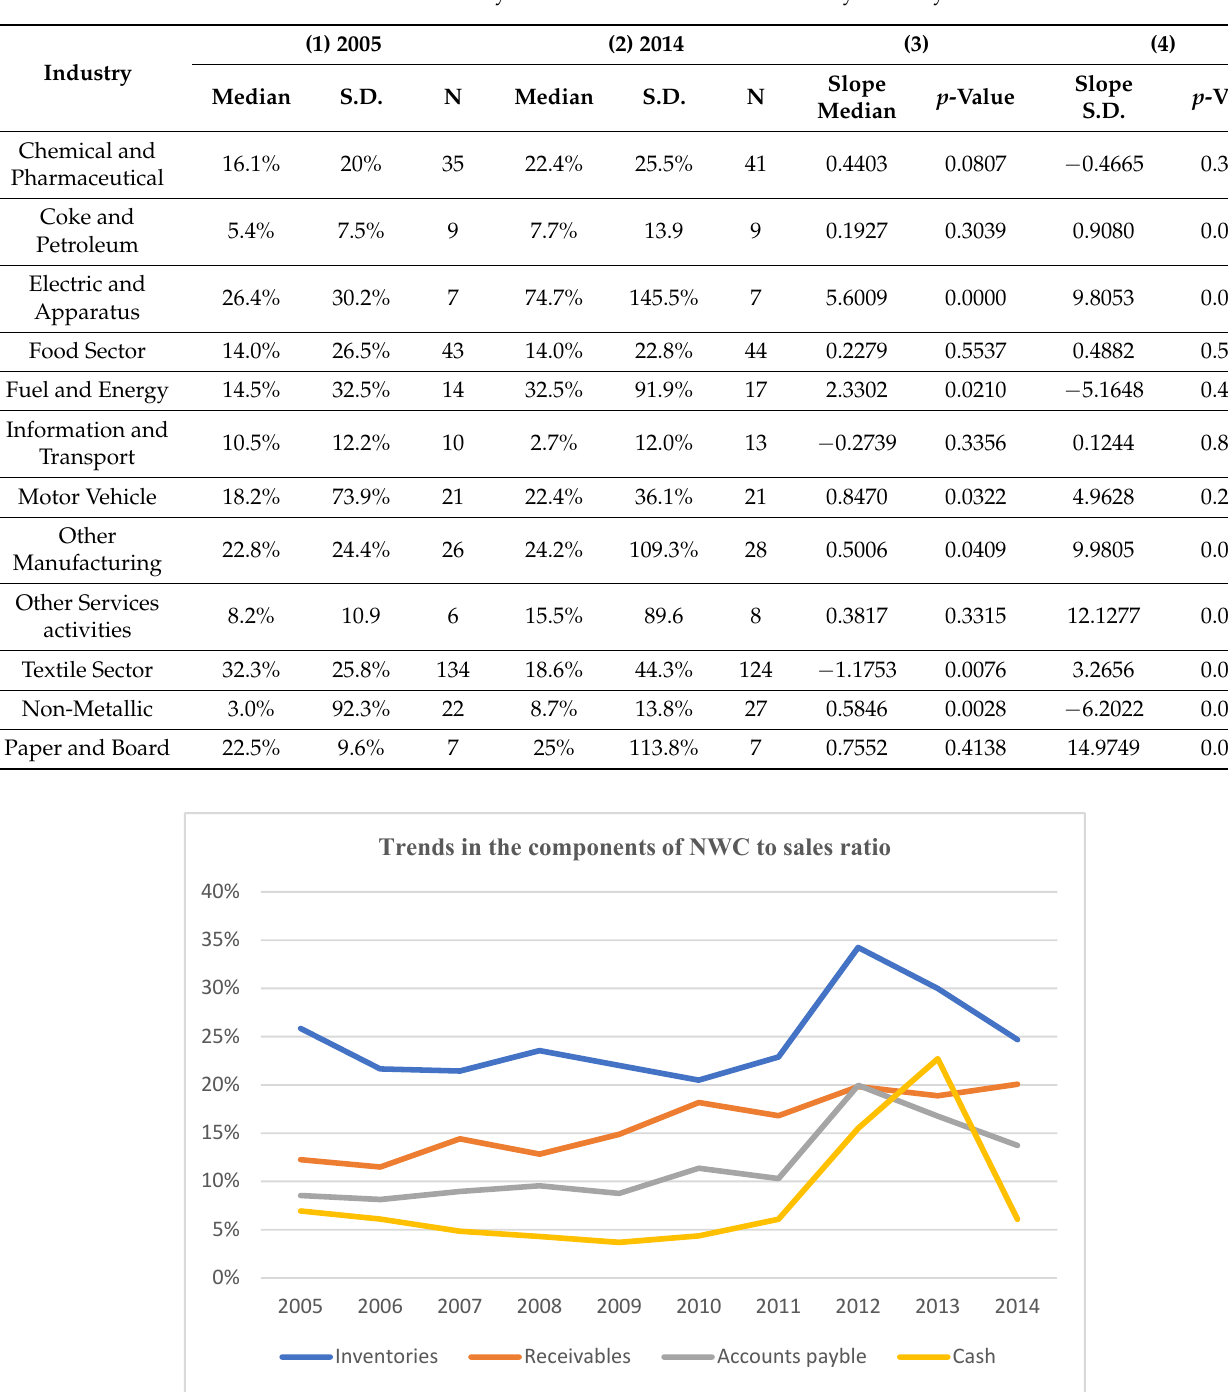
Table 1. Summary statistics for NWC to sales ratio by industry.